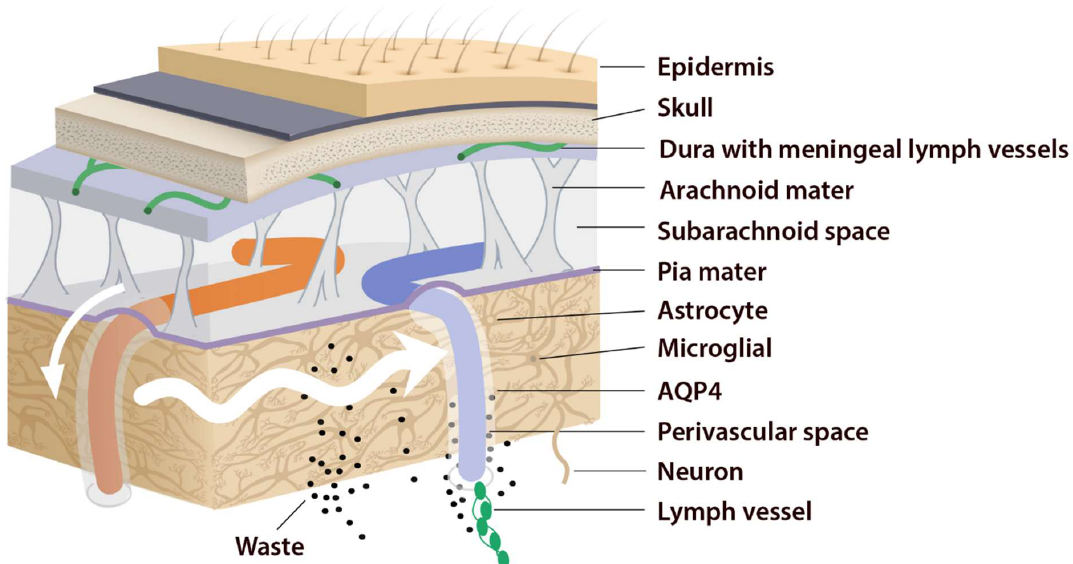
Figure 2. Periarterial influx of CSF into the brain tissue (small white arrow). CSF–ISF exchange supported by AQP4 channels in the vascular end feet plastered along the arterioles. From here, the fluid leaves the axons and moves towards the perivenous space in a path supported by astrocytes. Astrocytic AQP4 water channels facilitate this perivenous efflux of interstitial fluid, which drains to the dural lymphatic